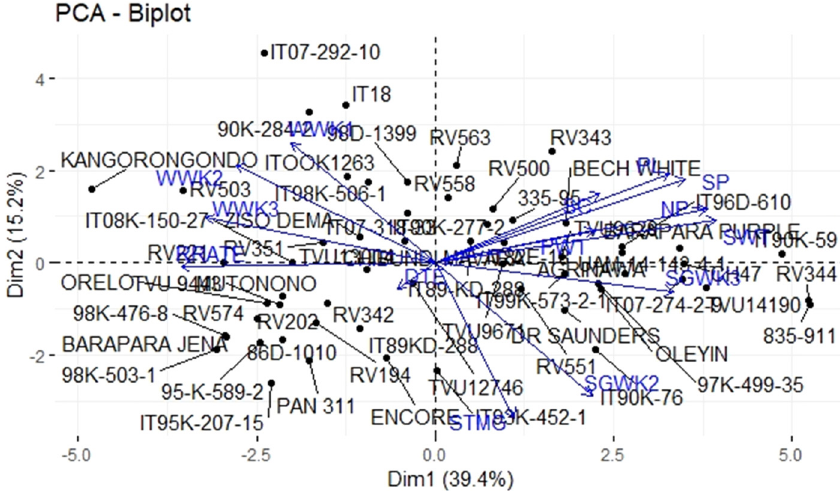
Figure 9: The contribution of various traits and accessions to drought tolerance at the seedling stage.